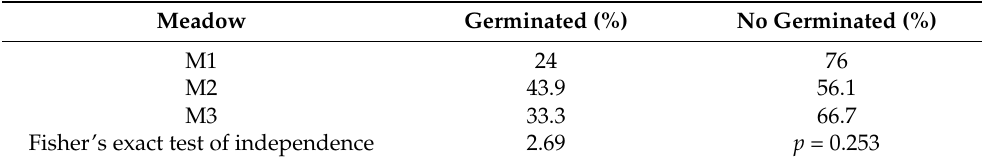
Table 4. Percentage of germinated and no germinated seeds. Comparison among meadows was done through Fisher’s exact test of